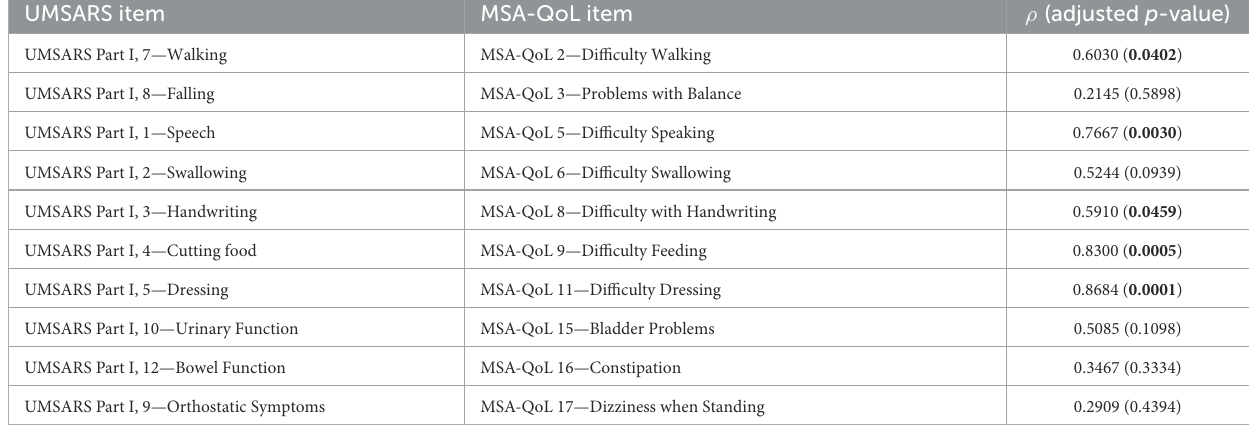
TABLE 3 Correlations of individual UMSARS items with closest corresponding individual MSA-QoL items. UMSARS